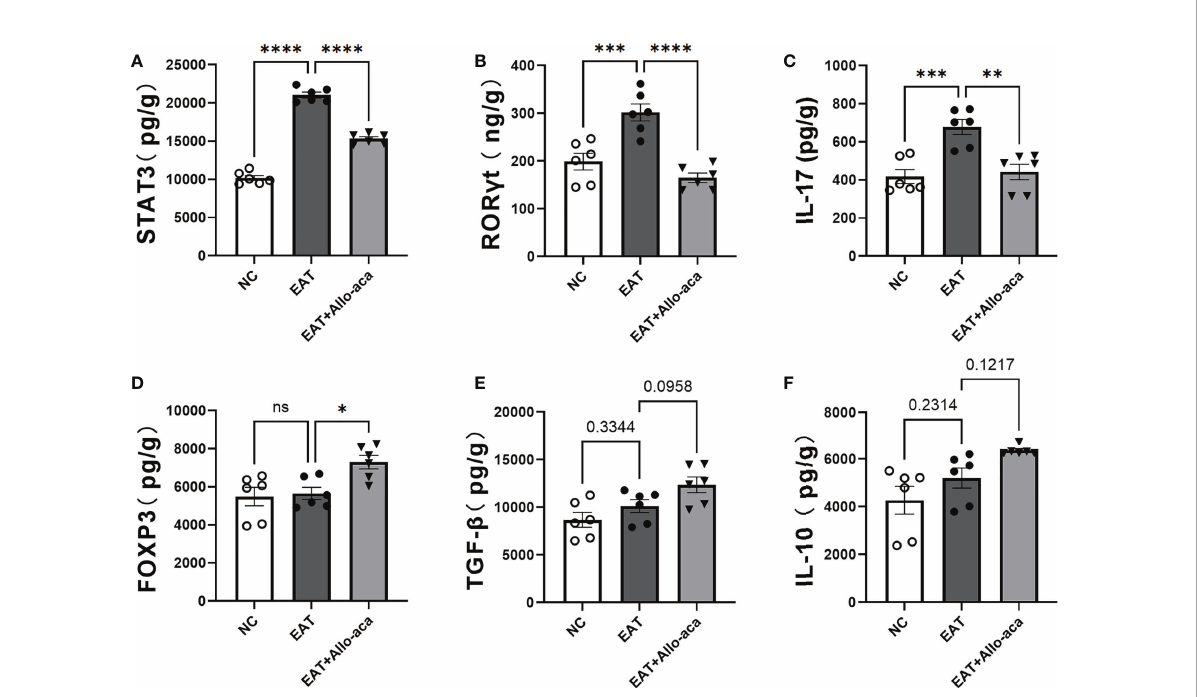
FIGURE 6 Effects of leptin receptor antagonists on in fl ammatory factors associated with hyper iodine-induced autoimmune thyroiditis in mice. (A-C) . The levels of STAT3, ROR g t and IL-17 in thyroid of EAT mice increased and Allo-aca decreased their levels. (D) . Allo-aca increased the level of FOXP3 in thyroid of EAT mice. (E-F) . Allo-aca mildly increased the levels of TGF- b and IL-10 in thyroid of EAT mice, but the change was not statistically signi fi cant. n =6. Data is expressed as mean ± SEM. ns : not signi fi cant, * P < 0.05, ** P < 0.01, *** P < 0.001, **** P < 0.0001.